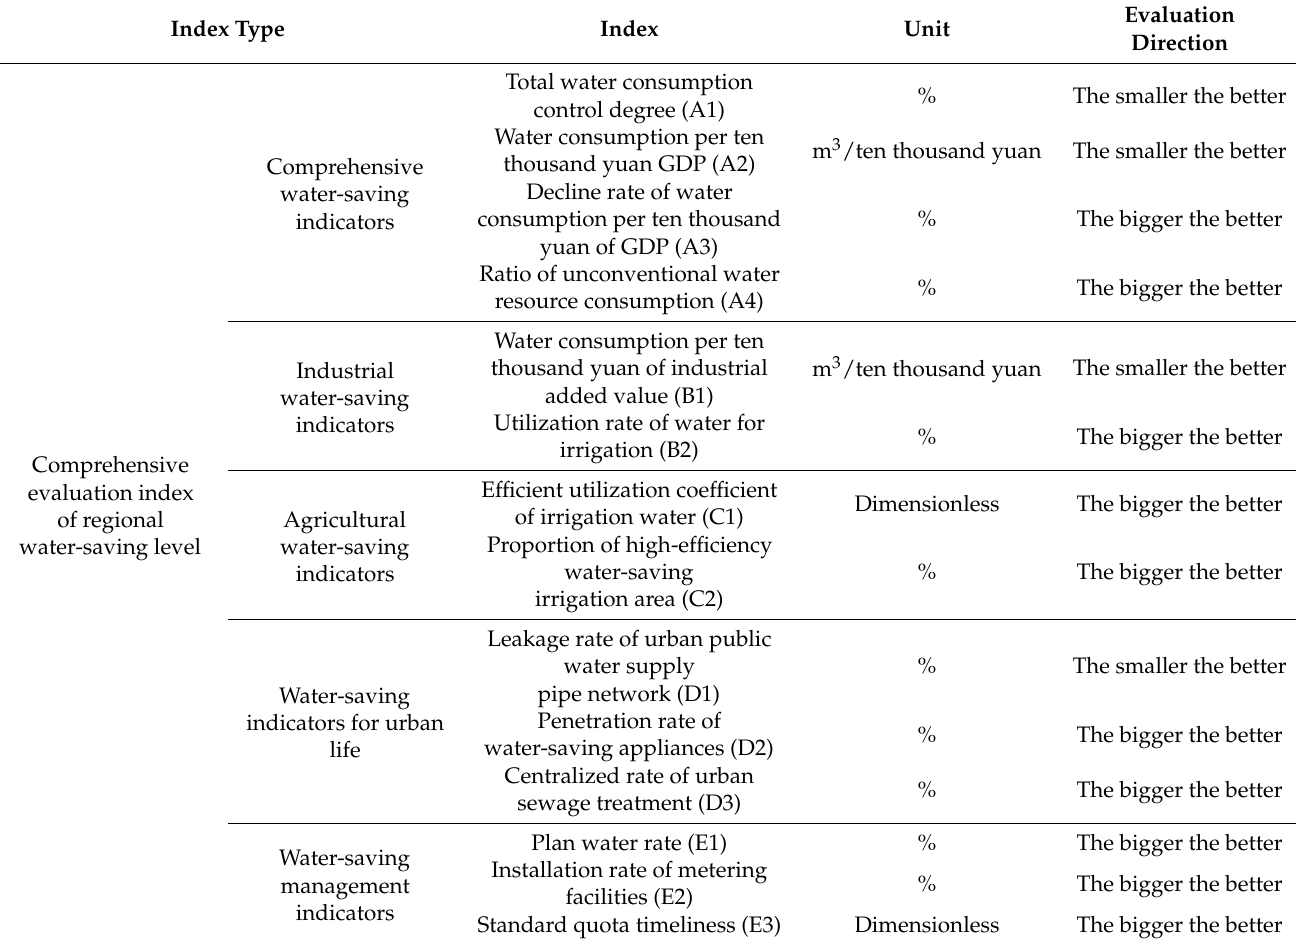
Table 1. Comprehensive evaluation index system of regional water-saving